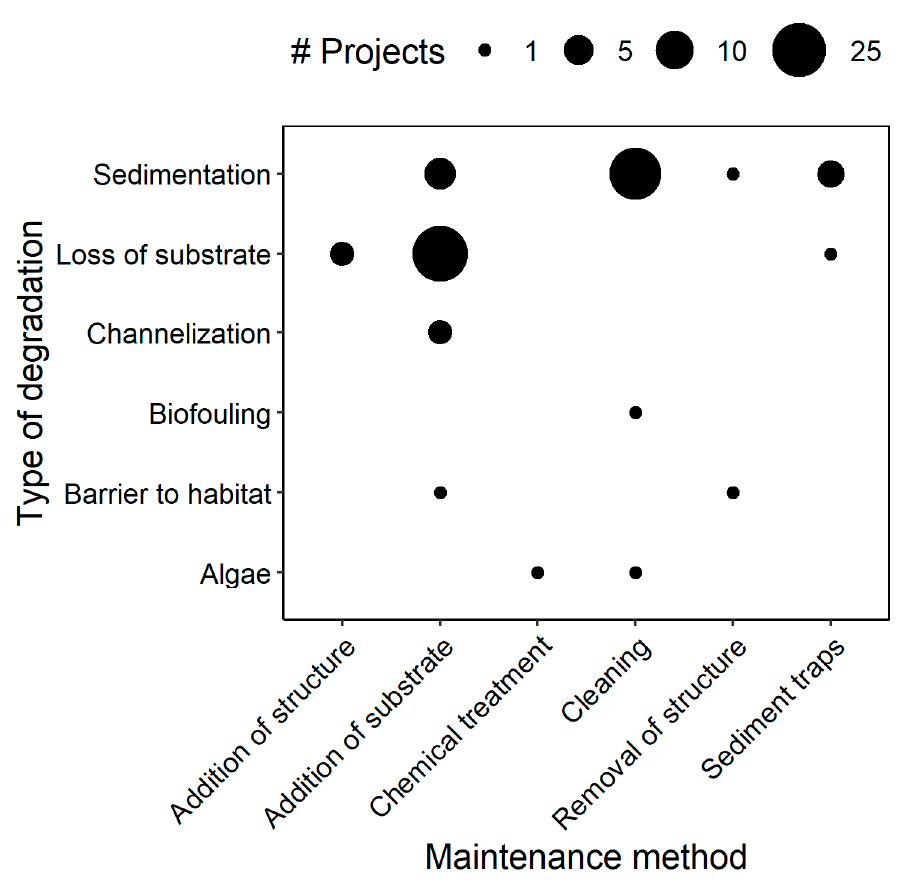
Figure 3. Numbers of rocky spawning habitat maintenance projects by type of degradation vs. the maintenance method used to treat the degradation. Note that each project may have more than one type of degradation and / or maintenance method.